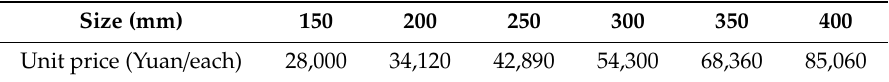
Table 3. Sizes and unit prices of diaphragm pressure relief valves.